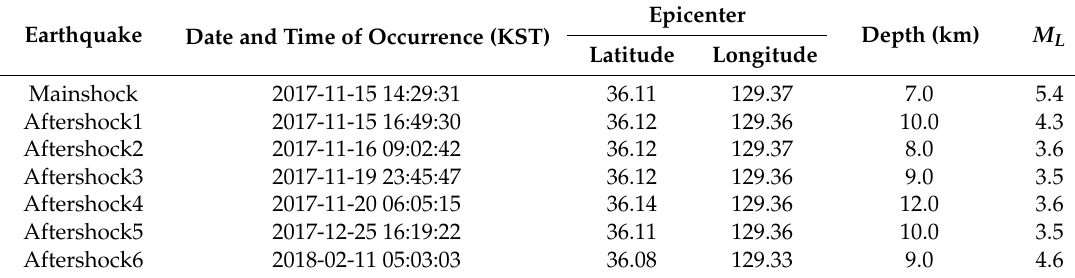
Table 2. Major events of the 2017 Pohang earthquake [1].